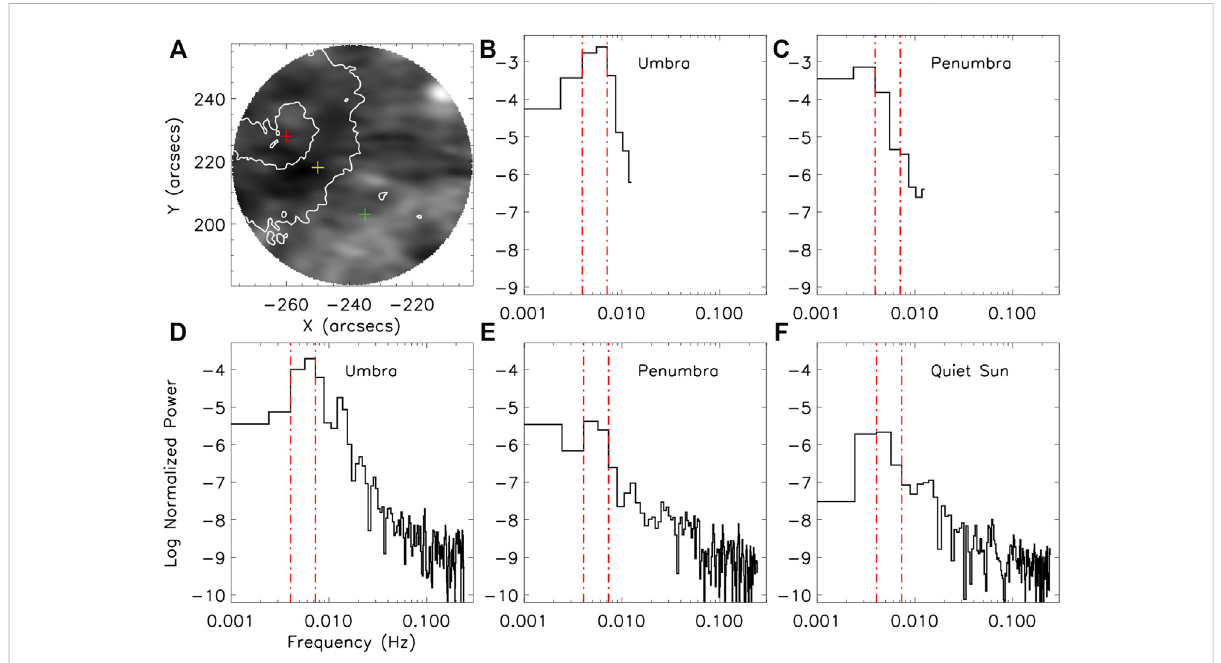
FIGURE 5 (A) ALMA Band 3image ofAR 12470 with 3 marked locations:in the sunspot umbra (a red plus sign), penumbra (yellow), and a quiet-Sun region (green); and (B – F) corresponding Fourier power spectra. The white contours in panel (A) mark the boundaries of the umbra and the penumbra, respectively. Panels (B,C) display the Fourier power spectra of GST H α near blue wing ( − 0.4 (A) . (D – F) of ALMA Band 3 data. The 3 min oscillation range is marked with red dotted – dashed lines. From Chai et al. (2022a). Reproduced by permission of the